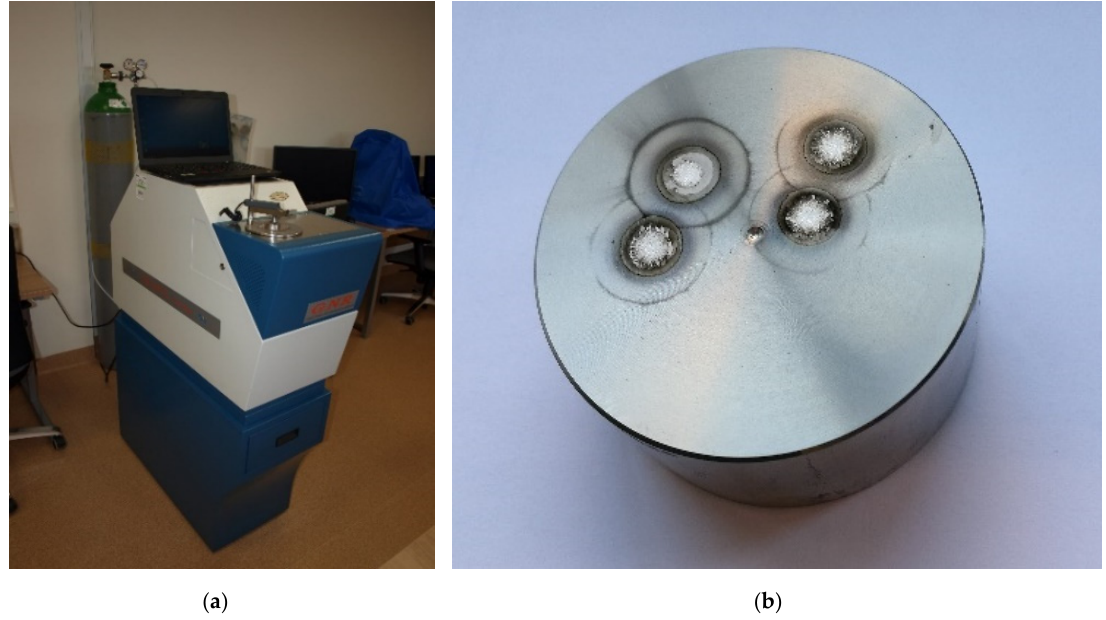
Figure 6. An optical spectrometer used for chemical composition test ( a ) and the view of the sample after four spark test ( b ).